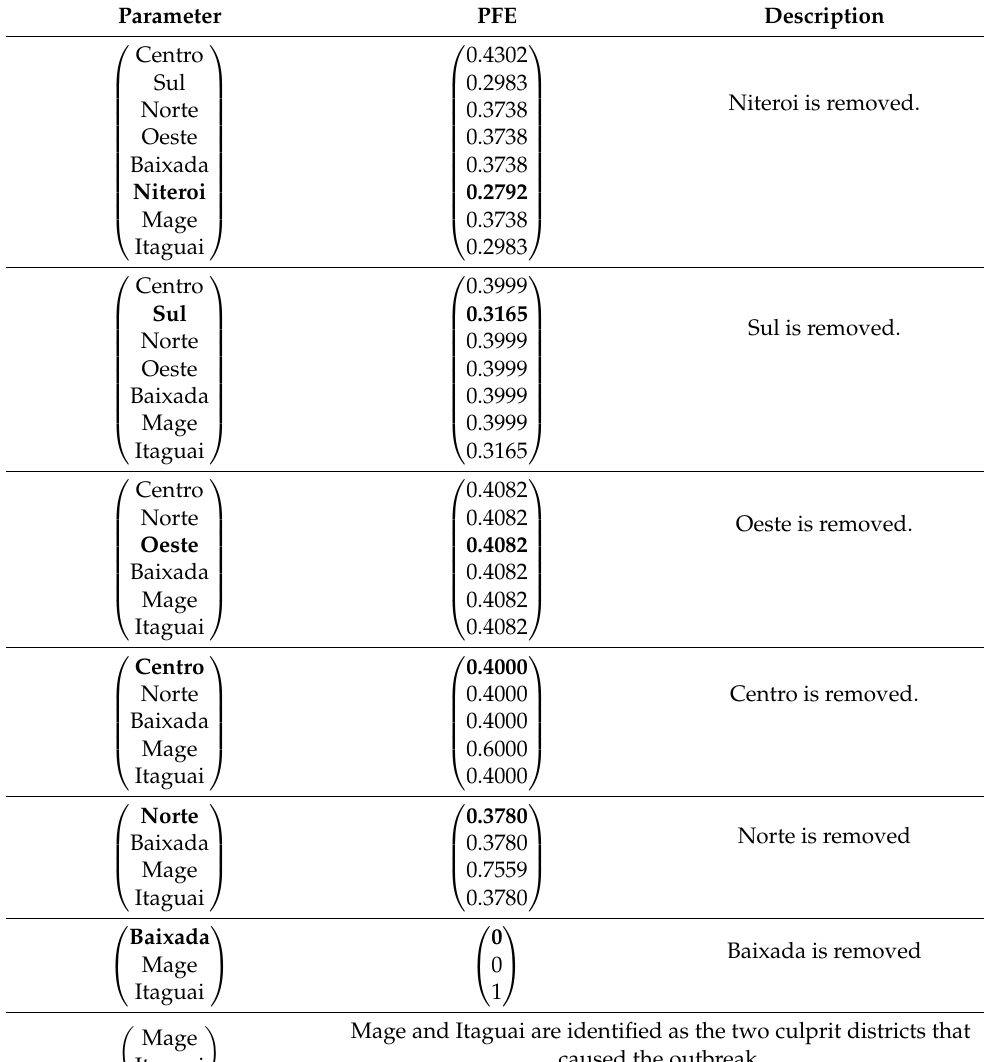
Table 3. The dynamic of MACS graph.